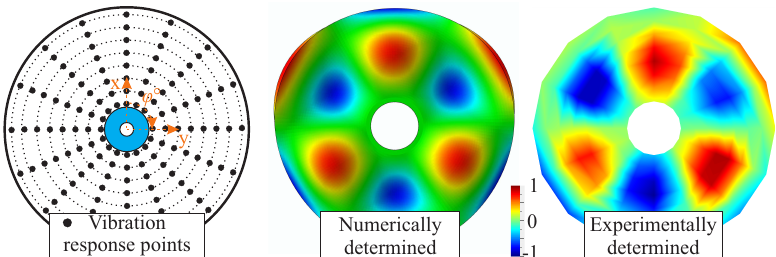
Figure 11. Comparison between the experimentally identified and numerically calculated mode shapes of an undamaged rotor.